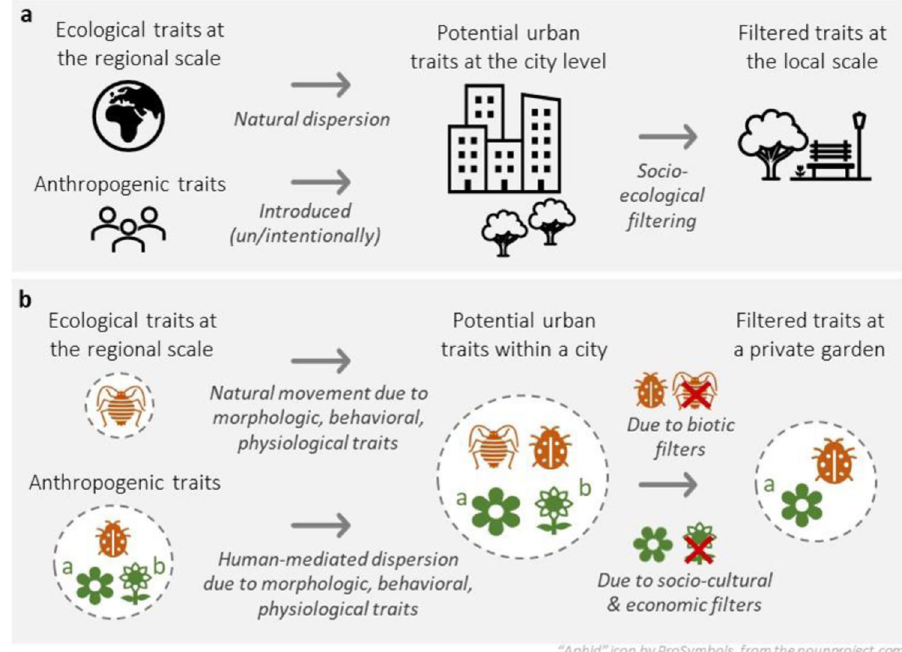
Fig. 2 The different trait combinations considered by the Socio-Ecological Traits Framework. The upper part of fi gure ( a ) represents the different combinations of traits that the Socio-Ecological Traits Framework considers: the ecological trait combinations are composed of the traits of native species, which naturally disperse to urban systems, and the anthropogenic trait combinations are associated with species introduced through human-mediated dispersion; these combinations constitute the potential urban trait combinations, which are affected by socio-ecological fi lters, leading to the fi ltered trait combinations at the local level. The lower part of fi gure ( b ) represents speci fi c examples of these combinations of traits: the ecological trait combinations are represented by the traits of aphids, which can naturally disperse to urban areas due to morphologic, behavioral, and physiological traits, and the anthropogenic traits are represented by the traits of ladybugs and two species of plants with different traits ( a , b ). These anthropogenic traits arrive to urban systems through human-mediated dispersion due to morphologic, behavioral, and physiological traits. Both these combinations of traits compose the potential urban traits. Considering biotic (for example, predation), socio-cultural (for example, cultural preferences), and economic (for example, budget constraints) fi lters, the fi ltered trait combinations in a private garden represent species with traits that have predatory feeding habits (ladybugs towards aphids), are culturally preferred (due to size and color), and have the lowest maintenance requirements (lower need for irrigation) (trait combinations of plant